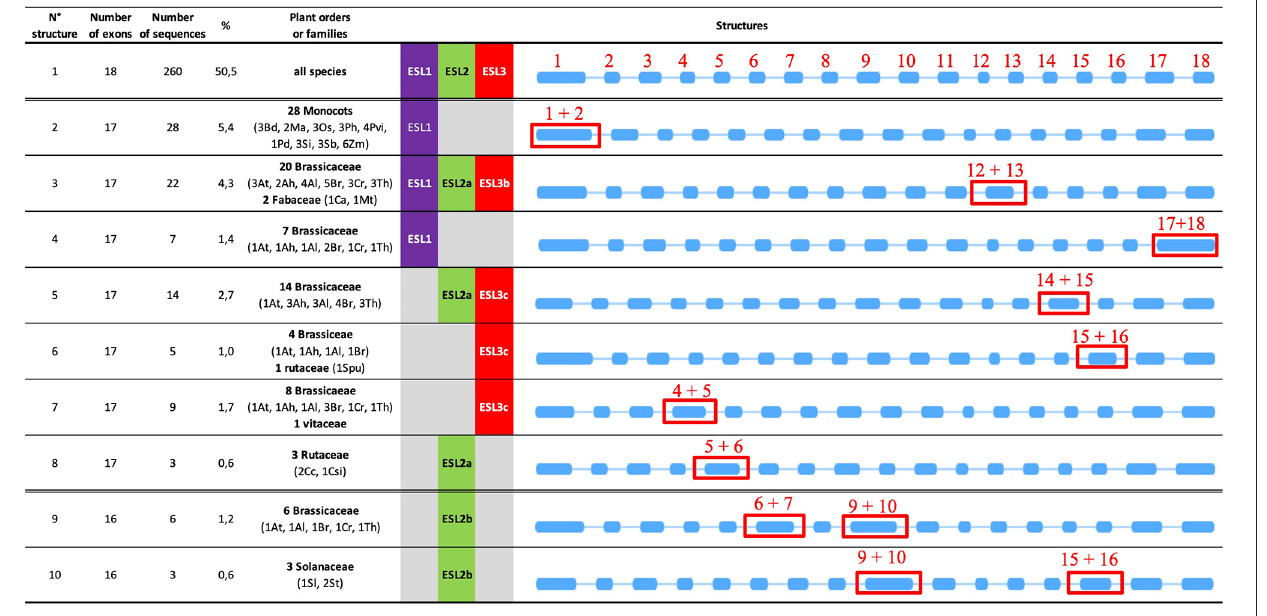
7 different intron/exon structures. To better understand